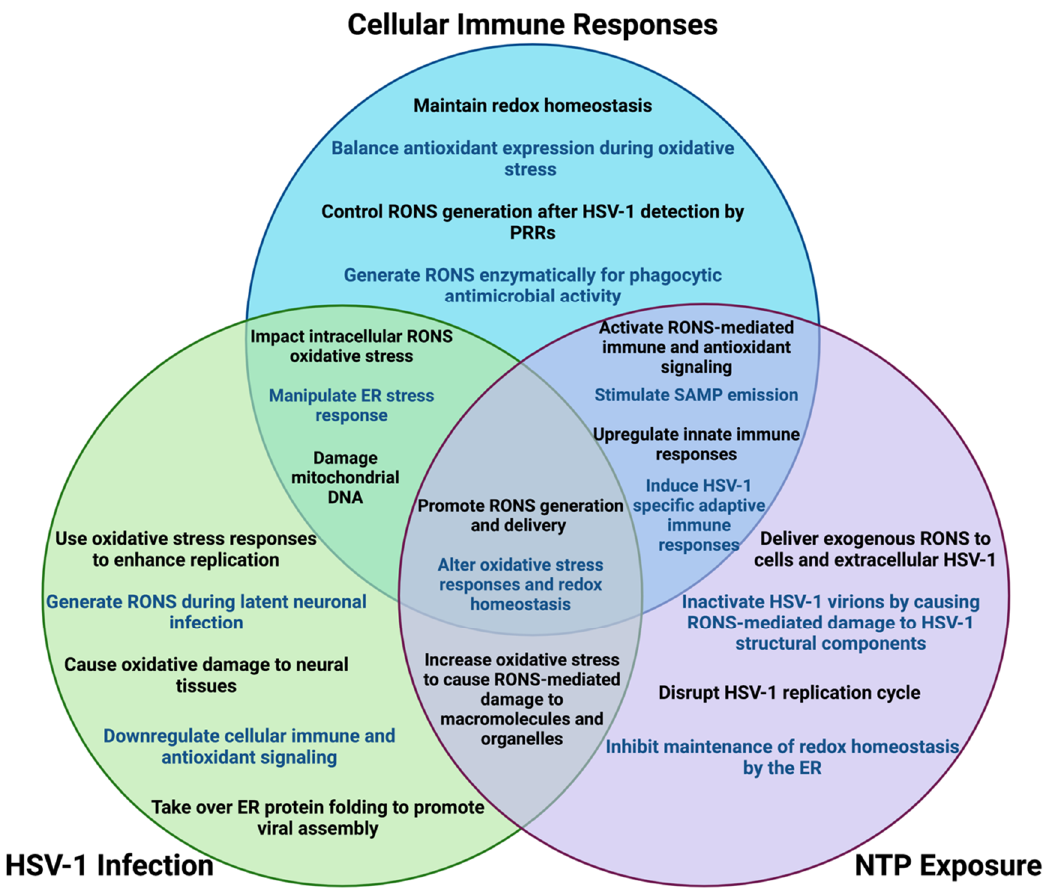
Figure 6. Summary of the roles and effects of oxidative stress in cellular immune responses, HSV-1 infection of host cells, and NTP exposure. The Venn diagram illustrates the unique and overlapping roles of RONS and oxidative stress in each aspect of a putative NTP-based treatment for HSV-1 infection.